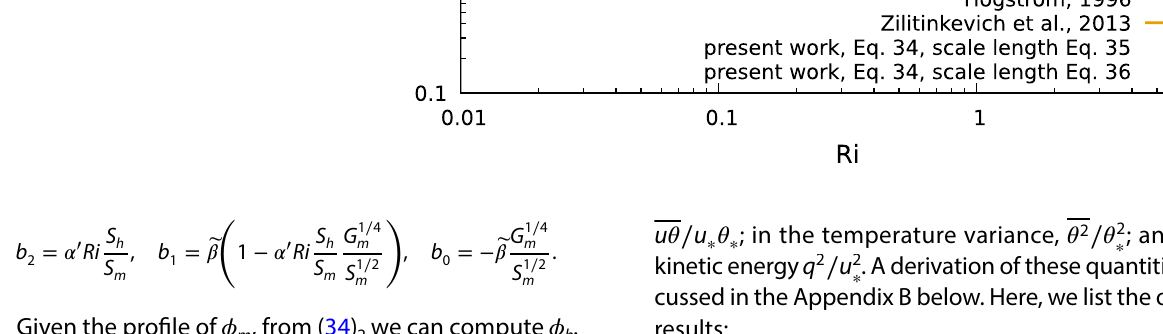
Fig. 2 Blue squares: similarity function from Eq. (34) as func- tion of Ri with the scale length parameterized as in Eq. (36). Open dots: the same, with the scale length from Eq. (35). Col- oured continuous lines: expres- sion from various